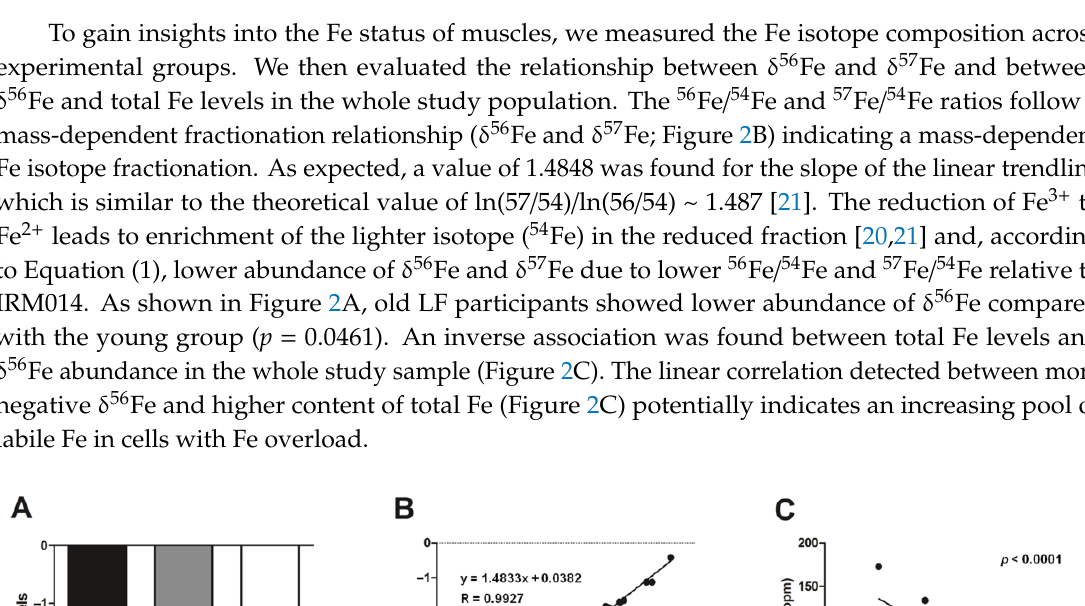
Figure 1. Protein levels of mitoferrin and frataxin in the vastus lateralis muscle of young and old participants. ( A ) Comparisons of mitoferrin levels by Kruskal – Wallis H statistics and of ( B ) frataxin by one-way ANOVA among young participants ( n = 11) and high- (HF, n = 16) and low-functioning (LF, n = 7) older adults. In ( A ) box plots represent median values (interquartile ranges), while in ( B ) bars represent mean values ( ± standard deviation) for the three experimental groups. Values are expressed in arbitrary units (a.u.) and representative blots are shown for each protein. * p < 0.05 vs. young group; # p < 0.05 vs. HF group.